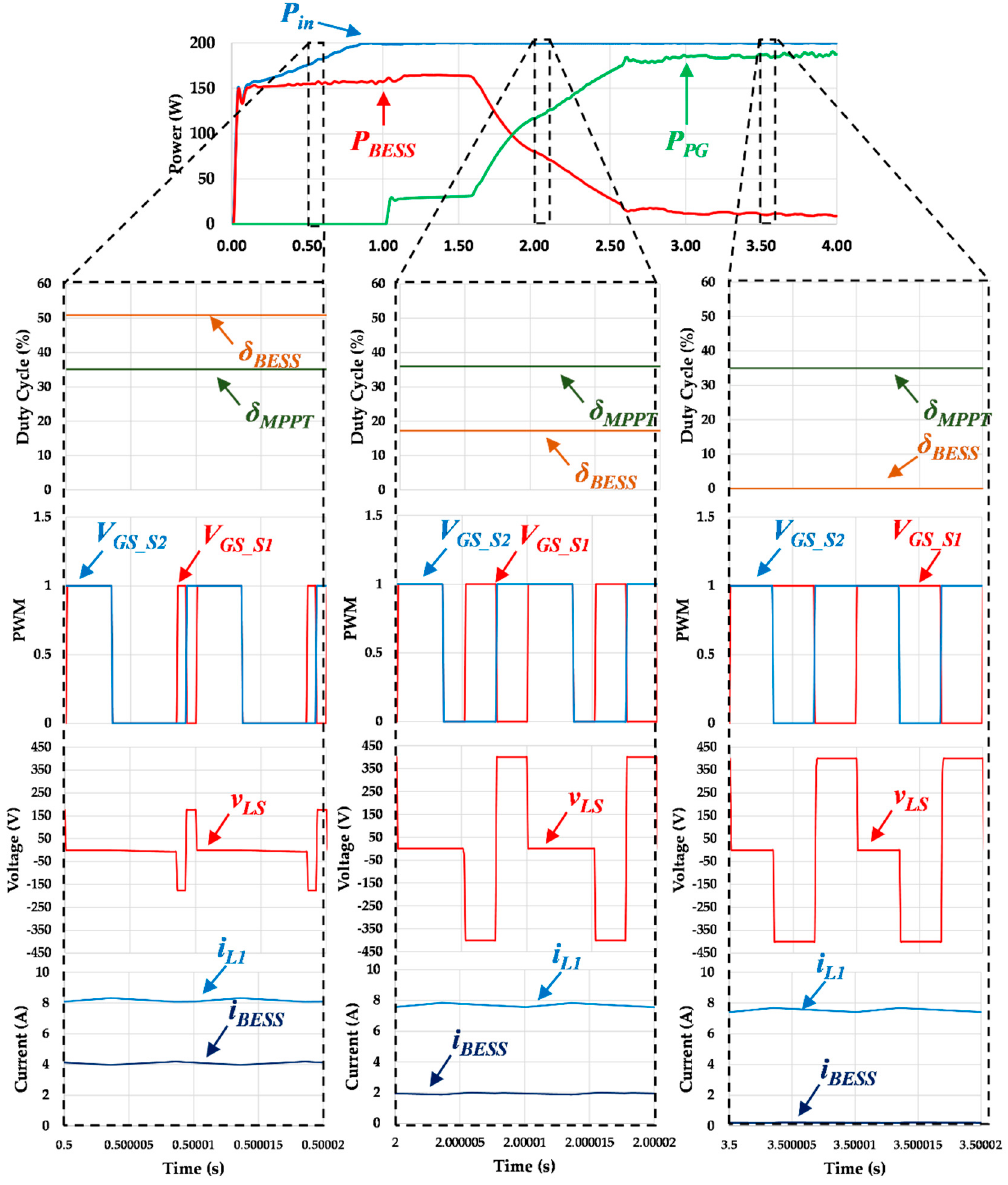
Figure 10. Identifiable influence of the δ MPPT and δ BESS control variables from the MPPT and BESS charging control algorithms at different time intervals: V GS_S 1 —MOSFET S 1 gate–source PWM signal; V GS_S 2 —MOSFET S 2 gate–source PWM signal; v LS —voltage at the secondary winding terminals of the